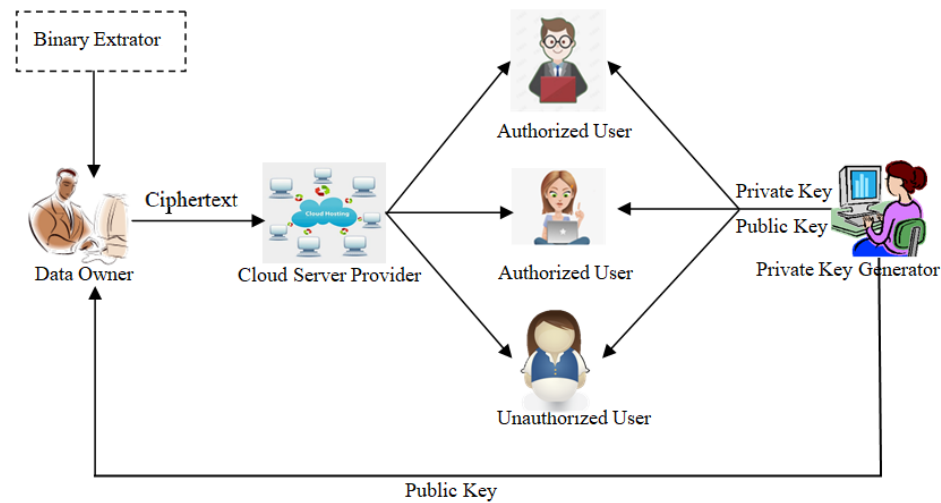
Figure 3. The entire structure of our anonymous IBBE scheme against leakage attack.